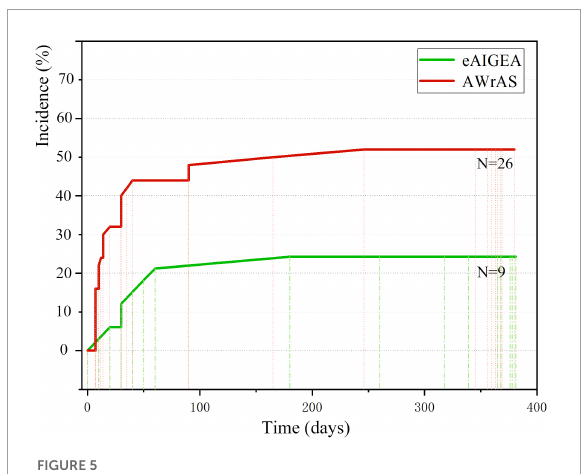
FIGURE5 The incidence time curve of the first reoperation